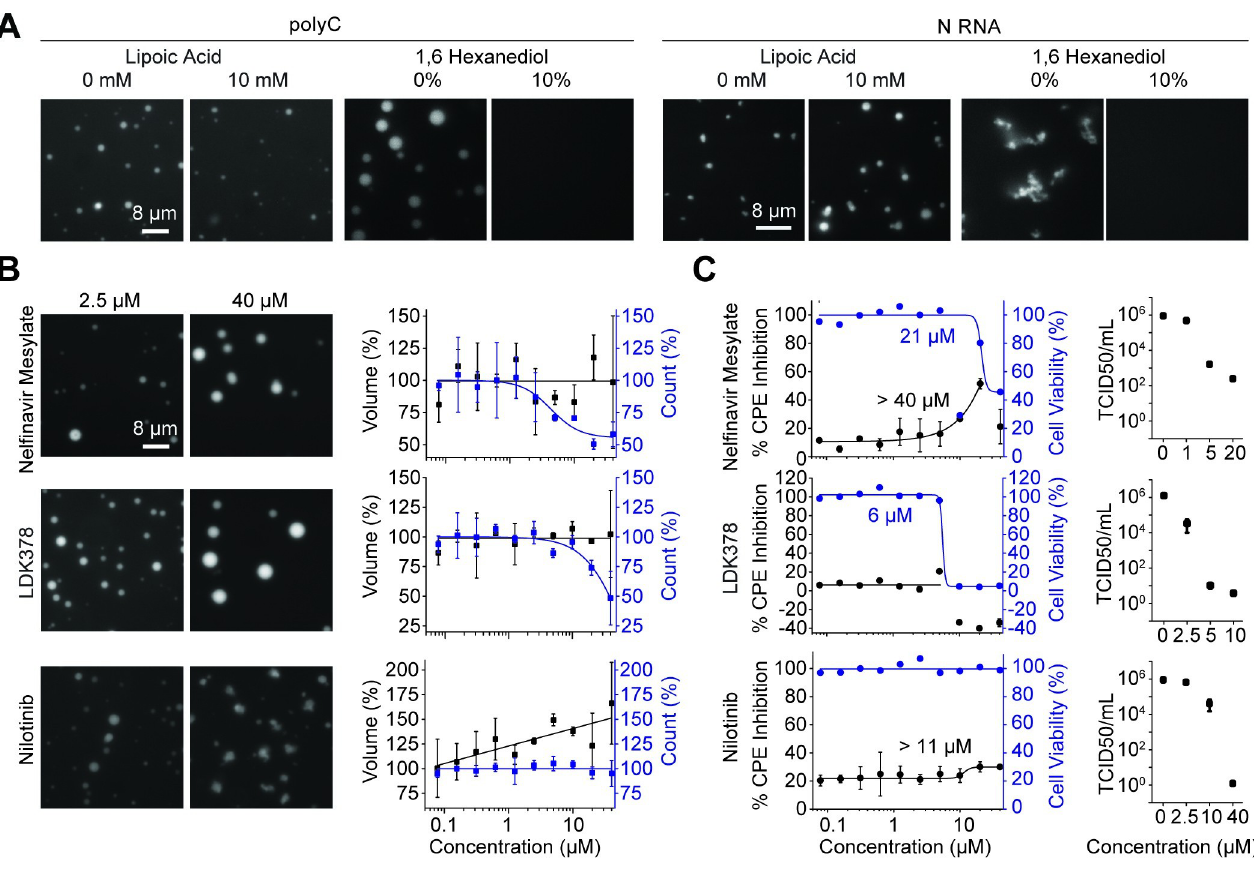
Fig 5. Identification of small molecules that alter phase separation of N in vitro and reduce viral titer in SARS-CoV-2 infected cells. (A) Condensates formed in the presence of 7.8 μ M N and either 50 ng/ μ L polyC or 18 nM 0-5 kb viral RNA were not affected by 10 mM lipoic acid but dissolved in the presence of 10% 1,6 hexanediol. (B) (Left) Examples of drugs that affected N phase separation with polyC in vitro. The N protein and polyC RNA concentrations were set to 7.8 μ M and 50 ng/ μ L, respectively. (Right) The percent change on the number (blue) and total volume (black) of N-polyC condensates settled per micron squared area on the coverslip under different drug concentrations (mean ± SD, n = 8 with 2 technical replicates). Solid curves represent a fit to a dose–response equation (see Methods). (C) (Left) Percent CPE inhibition (black, mean ± SD, 2 technical replicates) and cell viability (blue) of SARS-CoV-2–infected Vero-E6 cells treated with serial dilutions of drugs. Solid curves represent a fit to a dose–response equation (see Methods) to determine a half-maximal response constant EC 50 (S4 Table). (Right) Viral titer in SARS-CoV-2–infected Vero-E6 cells treated with serial dilutions of drugs as measured by a TCID 50 assay (mean ± SD, 3 technical replicates). Data underlying this figure can be found in S1 Data. CPE, cytopathic effect; N, nucleocapsid; SARS-CoV-2, Severe Acute Respiratory Syndrome Coronavirus 2; TCID, tissue culture infectious